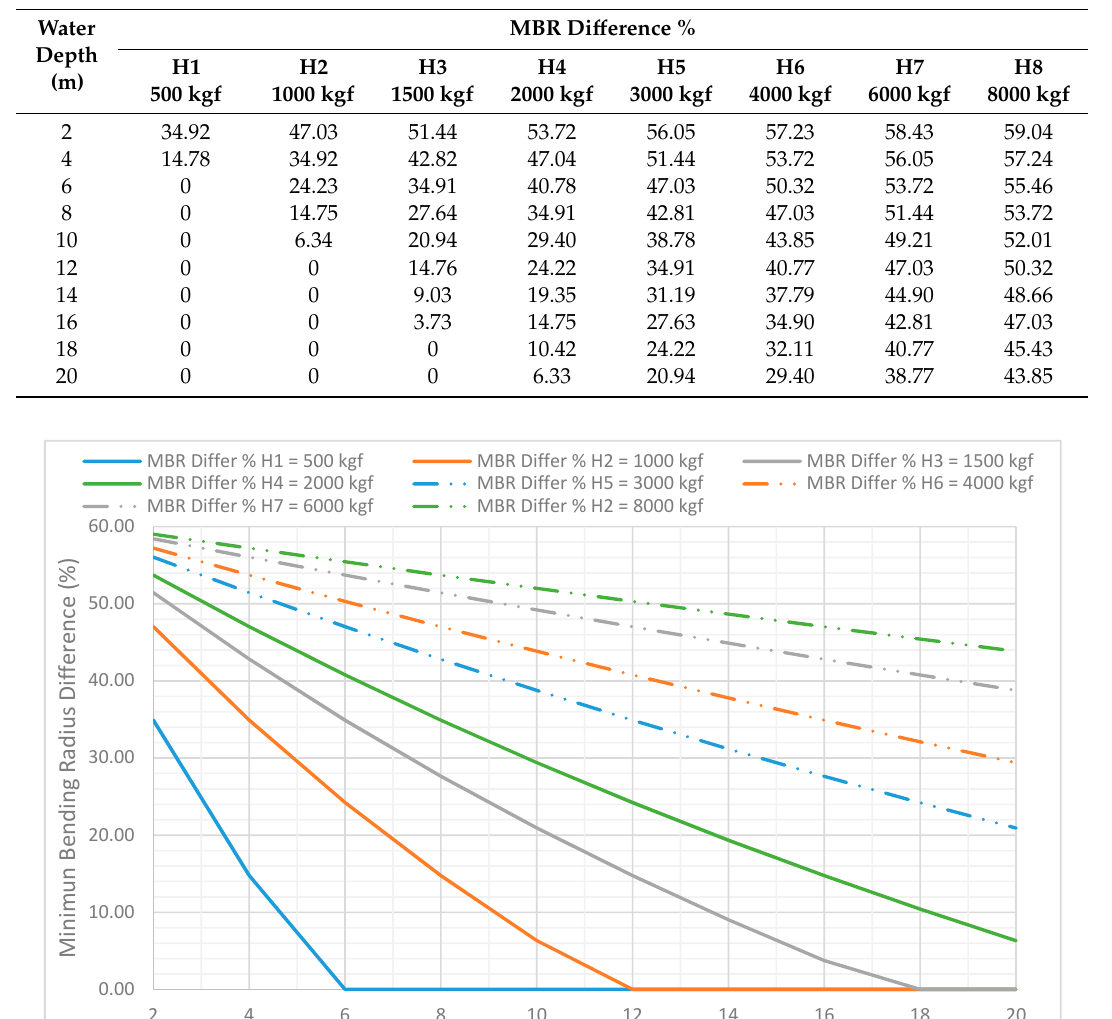
Table 4. MBR difference (%) comparing CS1 & CS2 using different bottom tensions (500 kgf–8000 kgf) Table 4. MBR di ff erence (%) comparing CS1 & CS2 using di ff erent bottom tensions (500 kgf–8000 kgf) and water depths (2 m–20 m). and water depths (2 m–20 m).